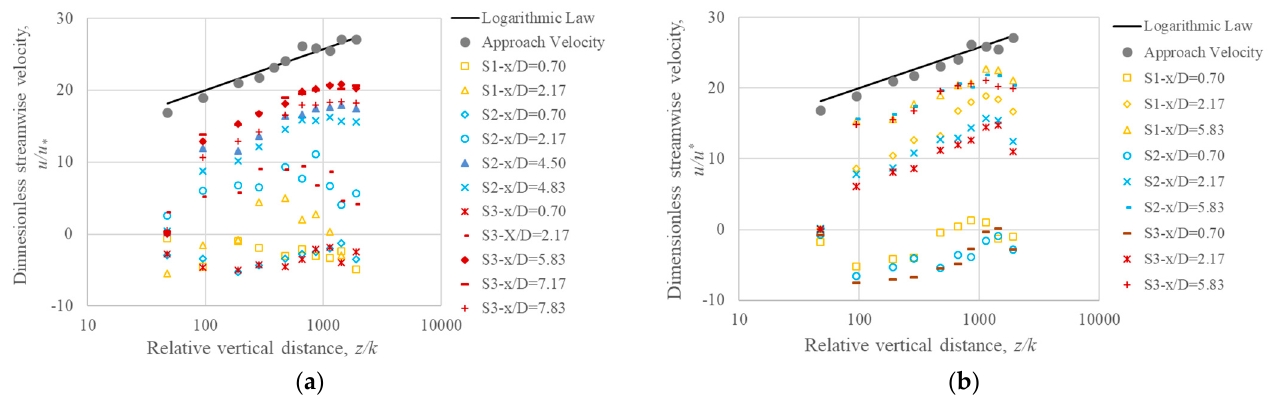
Figure 2. Vertical profiles of dimensionless streamwise velocity ( u/u * ) in the symmetry plane: ( a ) midstream and ( b ) downstream. A solid black line shows the classical logarithmic law.